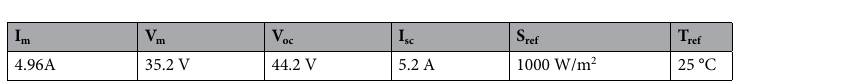
Table 1. PV panel simulation model parameters.